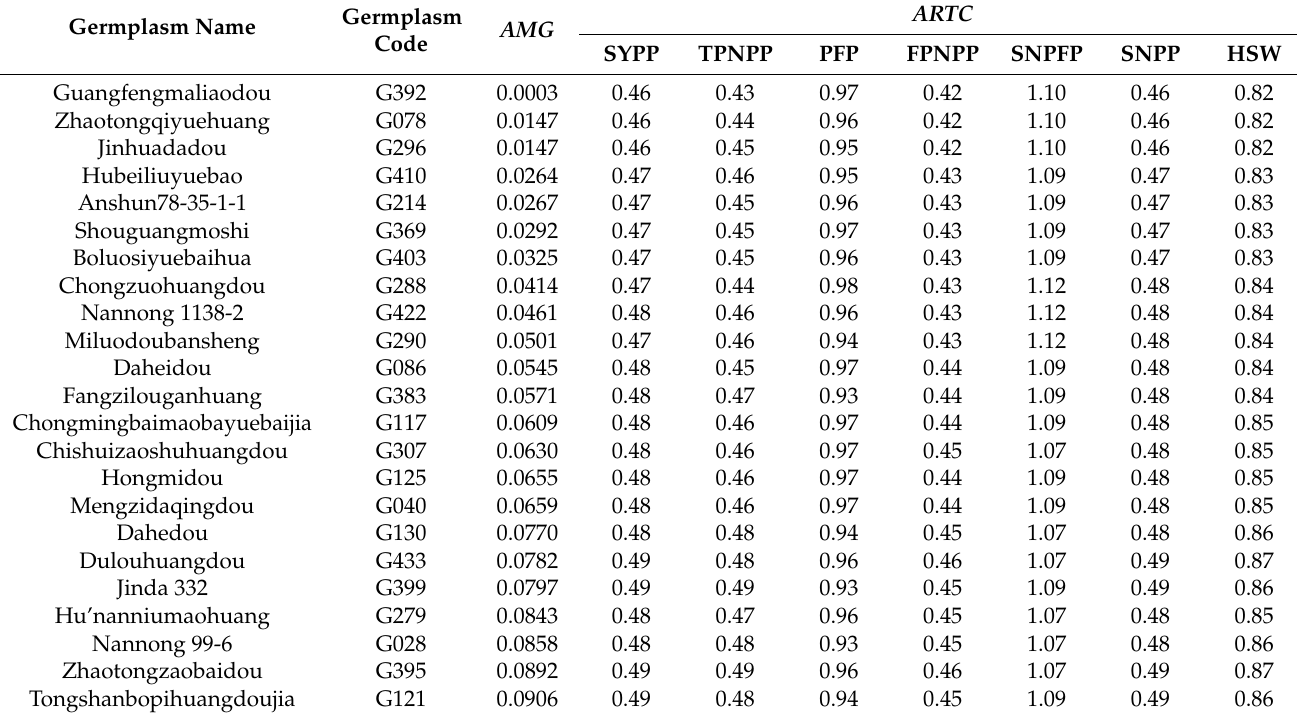
Table 8. ARTC s of seed yield and yield components for highly AR-susceptible soybean germplasms screened using the multiple traits comprehensive evaluation